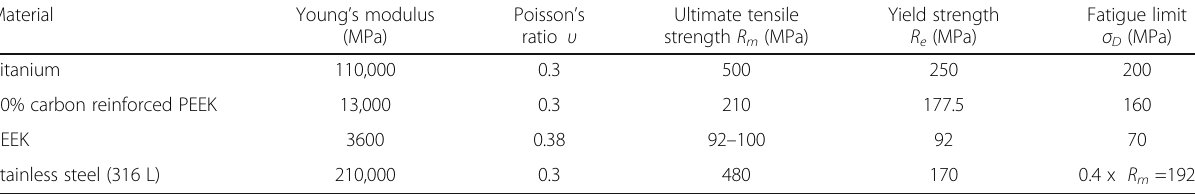
Table 1 Material parameters of the fixation devices. They were all retrieved from the literature